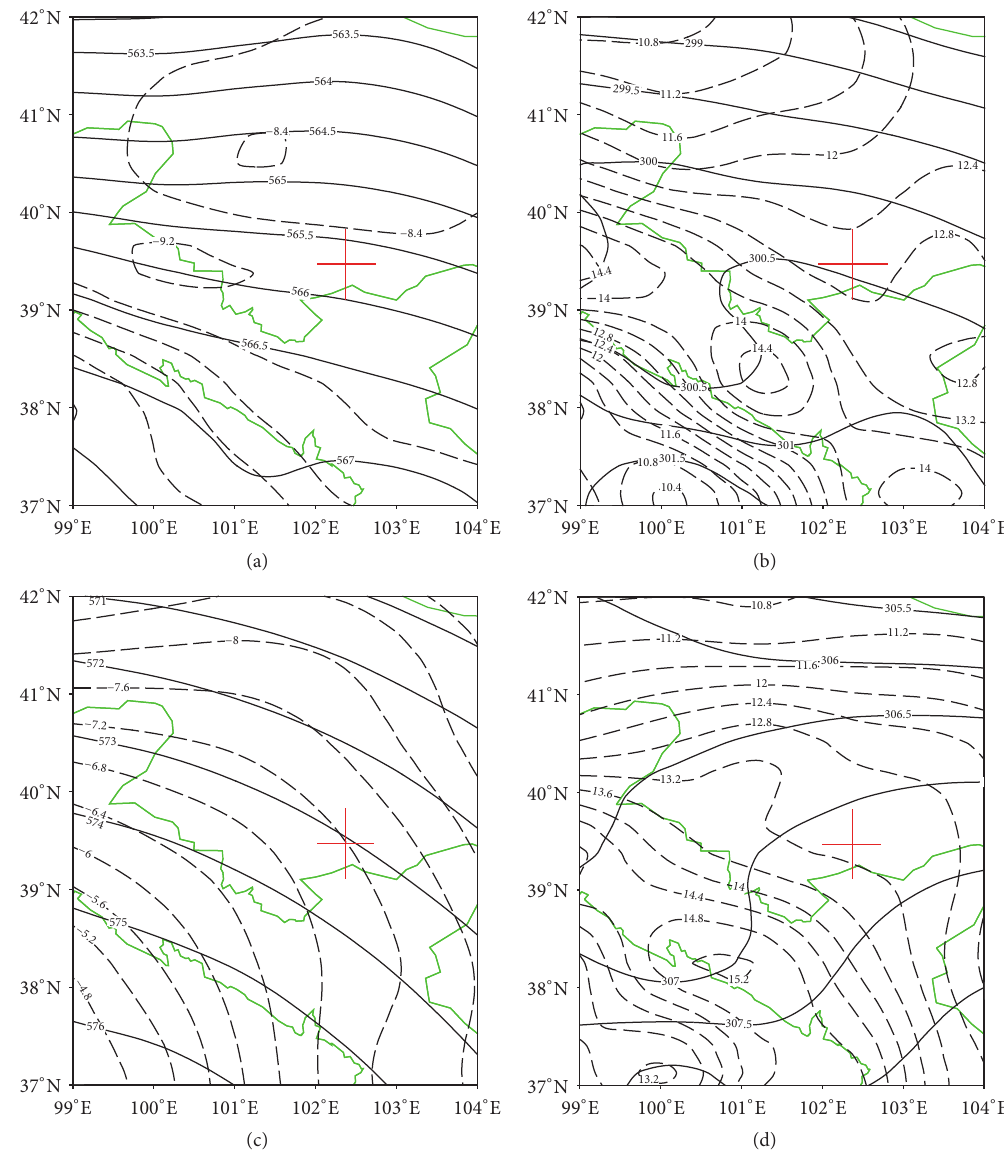
Figure 10: Atmospheric circulation in (a)-(b) 500 hPa and 700 hPa at 0600 UTC on July 4 and (c)-(d) 500 hPa and 700 hPa at 0600 UTC on August 30 (solid line: geopotential height, unit: gpm; dotted line: temperature, unit: Celsius degree; +: observation site).